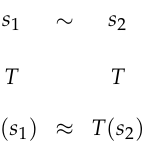
Figure 3. Simulation